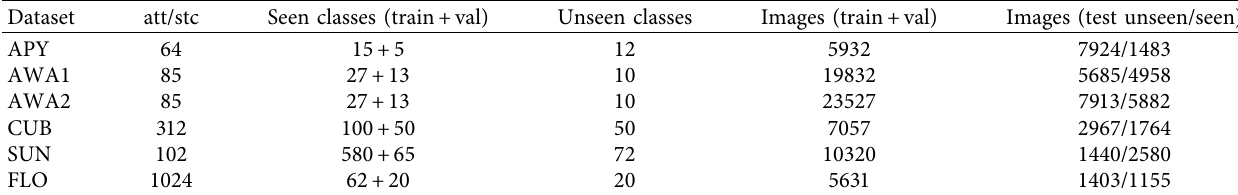
Table 1: Statistics of datasets.